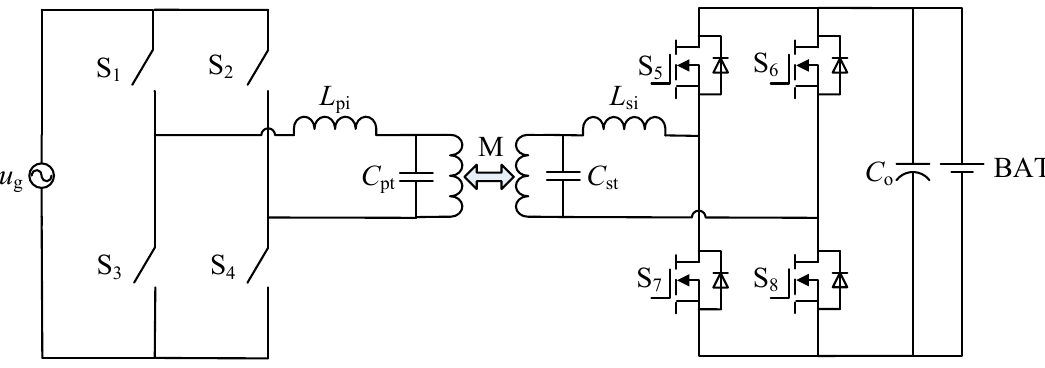
Figure 7. A bidirectional IPT single-stage topology based on matrix converter.